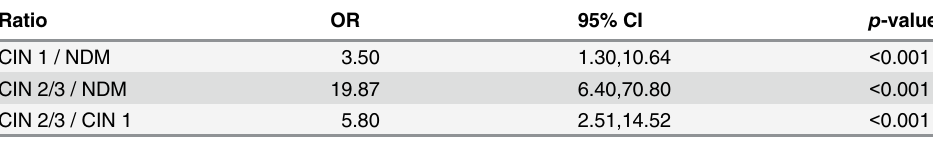
Table 2. Associations between RAP1 expression and risk of CIN